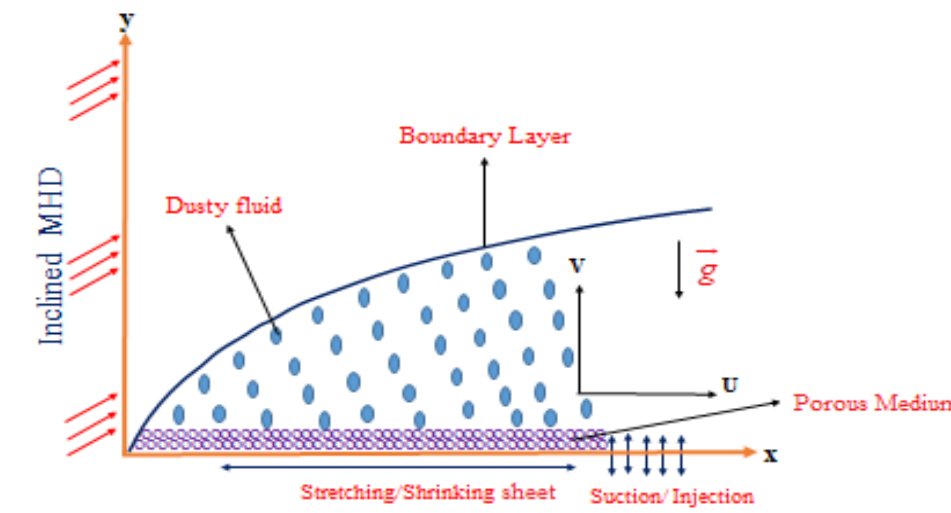
Figure 1. Physical model for stretching/shrinking boundary.